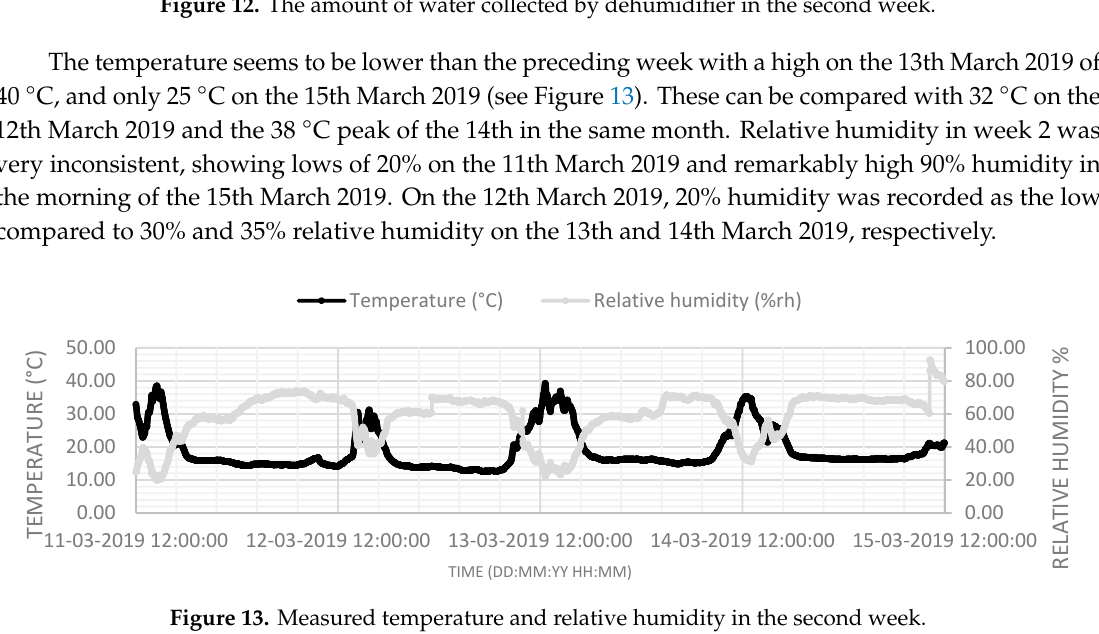
Figure 12. The amount of water collected by dehumidifier in the second week.